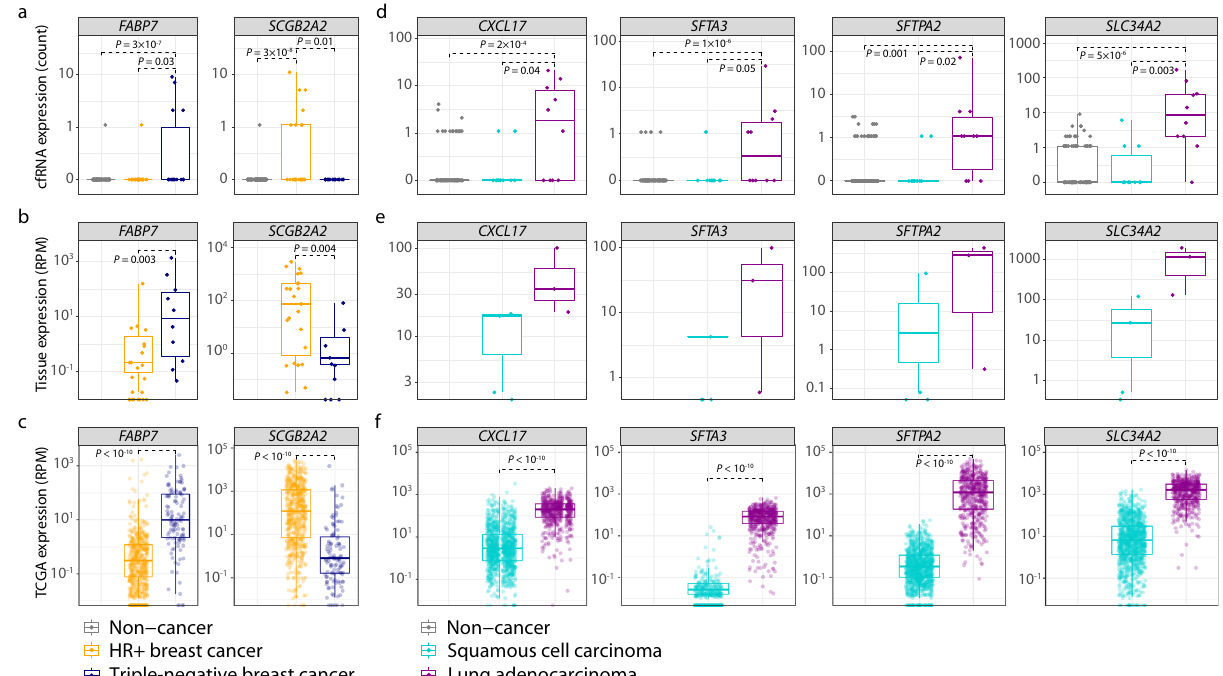
Fig. 4 Dark channel biomarker (DCB) genes exhibit cancer and subtype-speci fi c expression in cfRNA and tumor tissue. Expression (strict counts) of breast cancer-speci fi c DCBs in a cfRNA of breast cancer ( n = 24 HR + , n = 14 triple negative) and non-cancer participants ( n = 89), and in b matched breast tumor biopsies ( n = 23 HR + , n = 10 triple-negative). c Expression (RPM) of RNA in breast tumor tissue ( n = 575 HR + , n = 115 triple-negative) from The Cancer Genome Atlas (TCGA). Expression (strict counts) of lung cancer-speci fi c DCBs in d cfRNA of lung cancer ( n = 10 adenocarcinoma, 10 squamous cell carcinoma) and non-cancer participants ( n = 89), and in e matched lung tumor biopsies ( n = 4 squamous cell carcinoma, n = 3 adenocarcinoma). f Expression (RPM) of RNA in lung tumor tissue ( n = 1102 squamous cell carcinoma, n = 533 adenocarcinoma) from TCGA. P values from the two-sided Wilcoxon rank-sum method indicate signi fi cance levels for differential expression between cancer subtypes. Boxplots indicate the 25% (lower hinge), 50% (horizontal line), and 75% quantiles (upper hinge), with whiskers that indicate observations outside the hinge ± 1.5 × interquartile range (IQR). Outliers (beyond 1.5 × IQR) are plotted carcinoma, 3 adenocarcinoma) and tumor tissue samples from